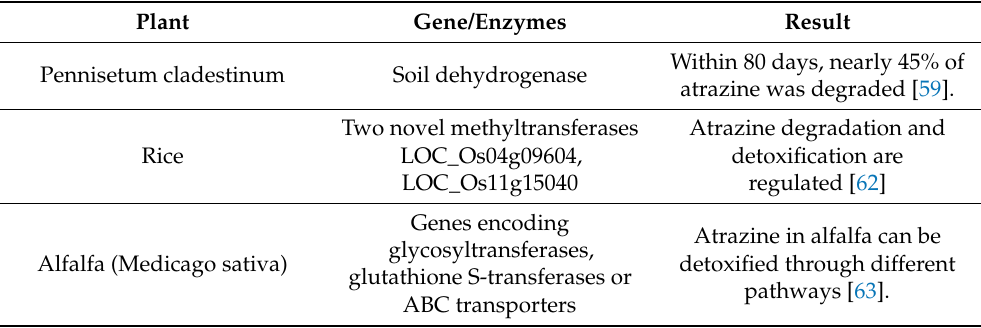
Table 6. Phytodegradation of aqueous